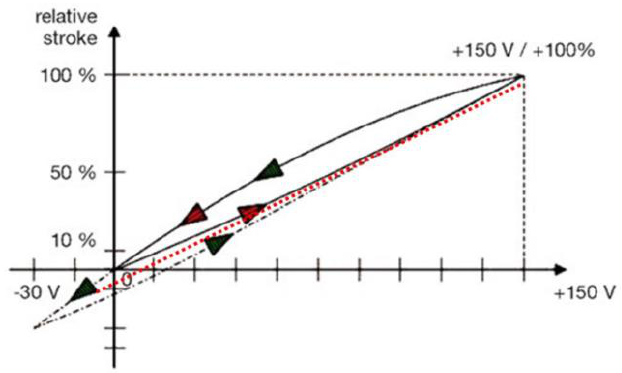
Figure 5. Simulink piezostack model.